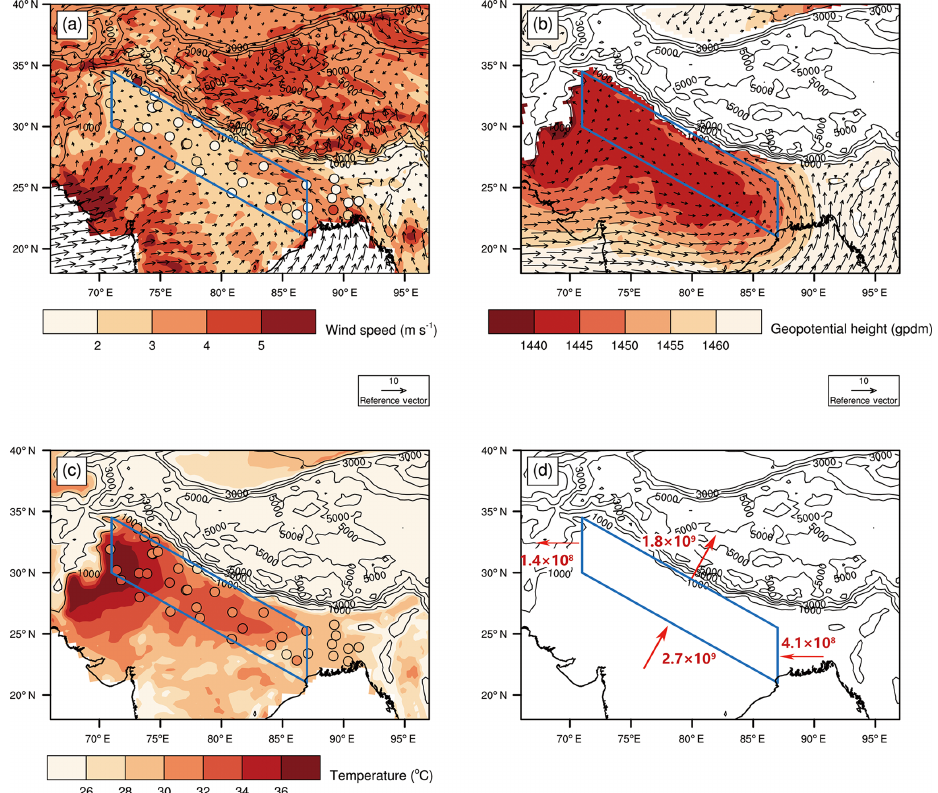
Figure 4. Spatial distributions of WRF-Chem-predicted meteorological variables from June to August 2010. (a) Wind flow and wind speed at 10m. (b) Wind flow and geopotential height at 850hPa. (c) Air temperature at 2m. (d) Ventilation rate (m 3 s − 1 ) of the four edges of the IGP. Circles in (a) and (c) show the observed wind speed at 10m and air temperature at 2m, respectively.